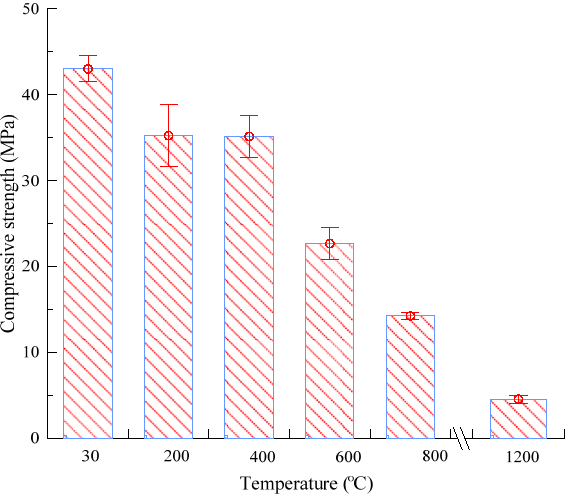
Figure 11. Compressive strength of PVA-ECC specimens at ambient and high temperatures.